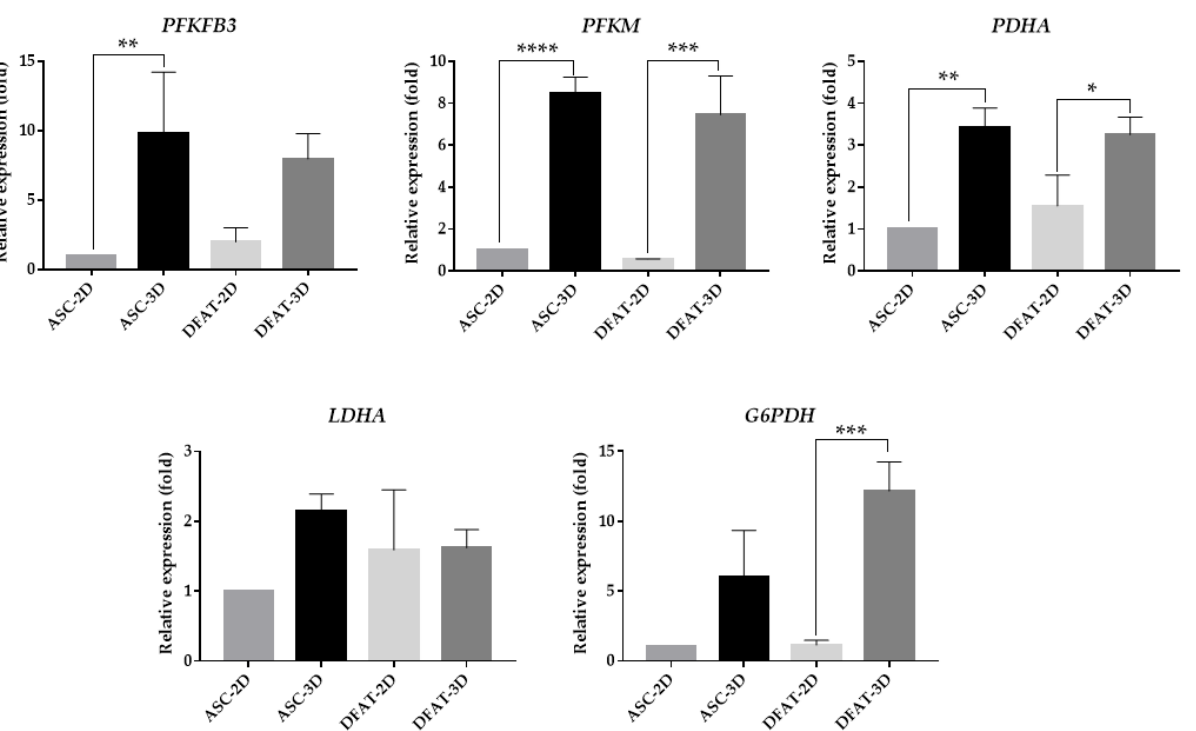
Figure 12. Relative expression of genes encoding for the main glycolytic enzymes in ASCs and DFATs cultured as a 2D monolayer and 3D spheroids. The results are presented as a mean value of 4 experiments ± SD, for * p < 0.05, ** p <0.01, *** p < 0.001, **** p < 0.0001.